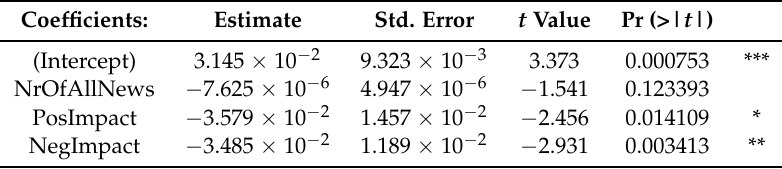
Regression analysis for volatility of mean bond spread difference from the